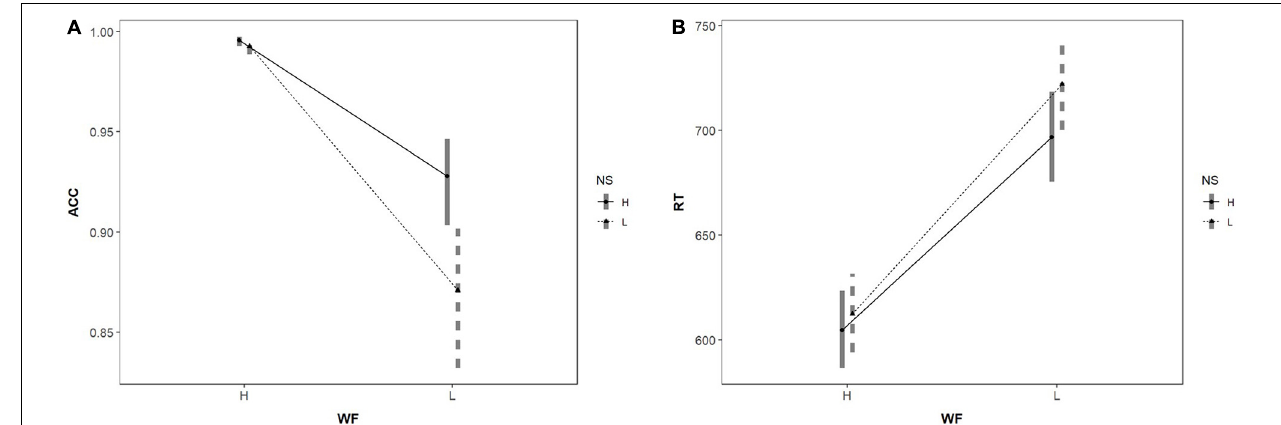
FIGURE 1 | Interaction of NS and word frequency in predicting (A) word recognition accuracy rate, and (B) word recognition reaction time. WF is word frequency, which has two levels: high (H) and low (L); NS is neighborhood size: high (H) and low (L). The Error bar refers to the 95% confidence interval. Same below.